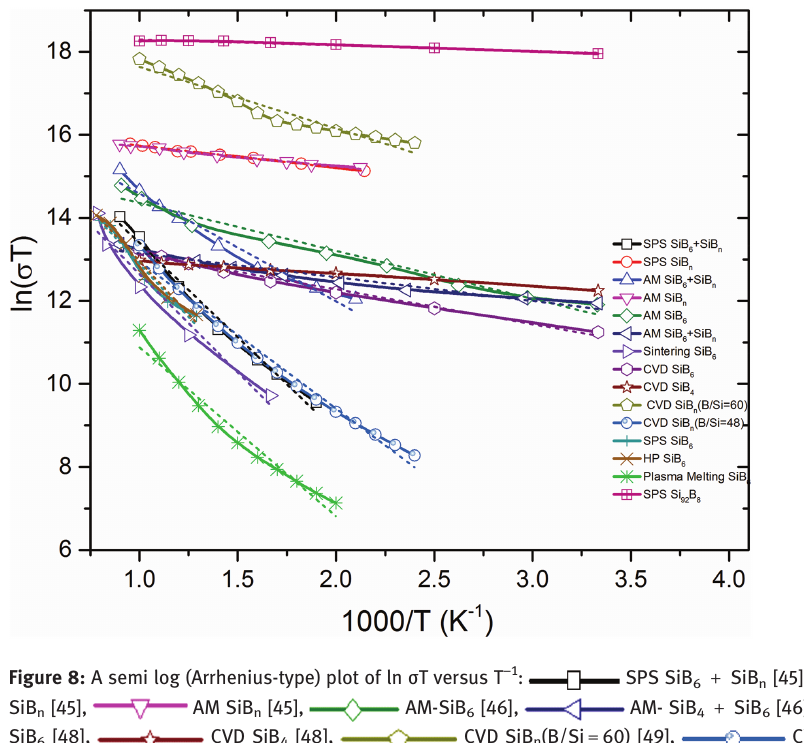
Figure 8: A semi log (Arrhenius-type) plot of ln σ T versus T − 1 :